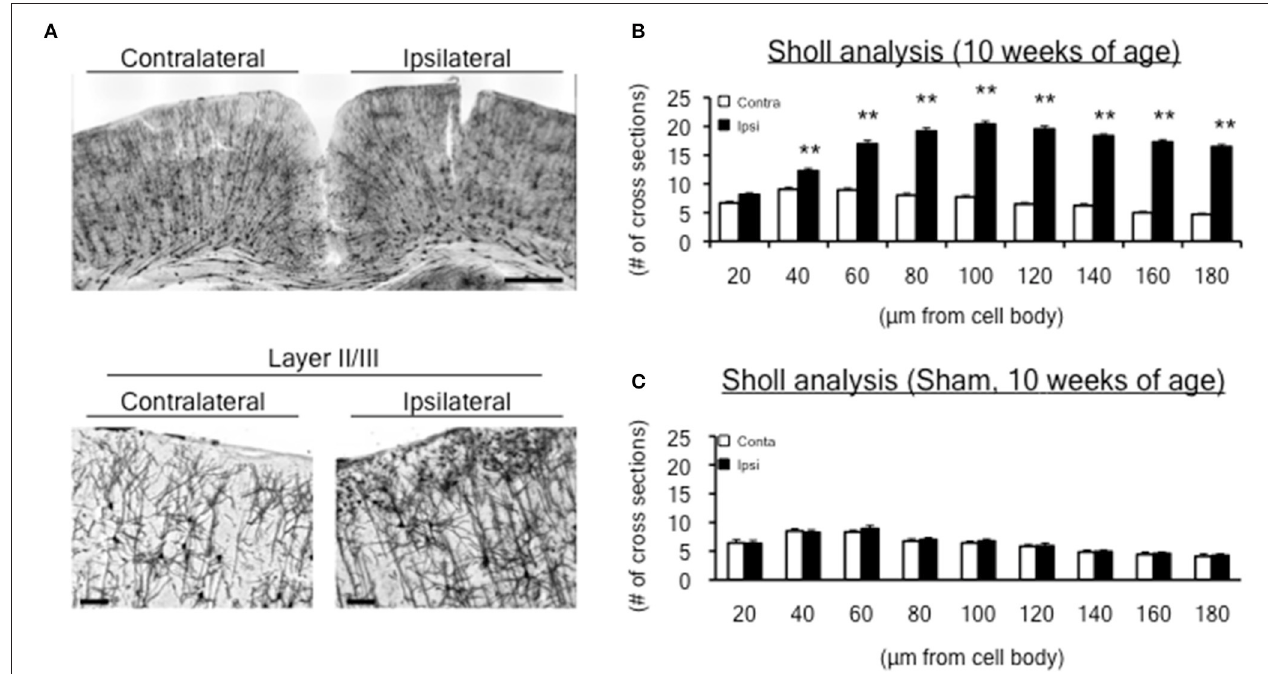
FIGURE 3 | Dendrite morphological changes in the motor cortex at 10 weeks of age. (A) We performed Golgi staining on brain slices, focusing on the hindlimb motor cortex. We particularly focused on layers I-III, in which histological changes were observed in our previous study. (B) To evaluate dendrites projecting from a cell body, a total of 135 Golgi-positive neurons in both ipsilateral and contralateral sensorimotor cortex were assessed by Sholl analysis in the neonatal WMI model ( n = 5) at 10 weeks of age. Sholl analysis revealed that the number of cross sections increased over 40 µ m from cell bodies on the right (ipsilateral H-I) side of the cortex. (C) Dendrite projections of 27 Golgi-positive neurons in the sham-operated right sensorimotor cortex were similar to those in the left cortex, which was equivalent to the left (contralateral control) side of the WMI group in B. ** p < 0.01 by Mann-Whitney U -tests. Scale bar, 100 µ m in lower figures. Data are presented as mean ±